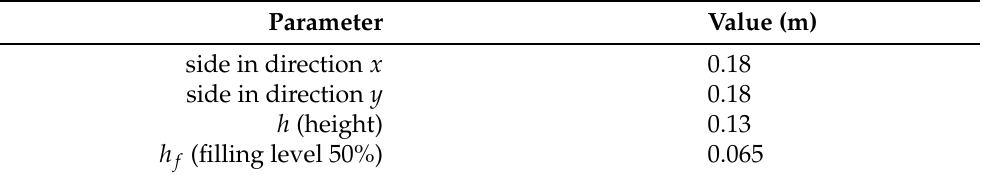
Figure 4. Configuration with one box-shaped tank placed underneath the BFF center of mass. Table 1. Tank geometry—Case study 1.